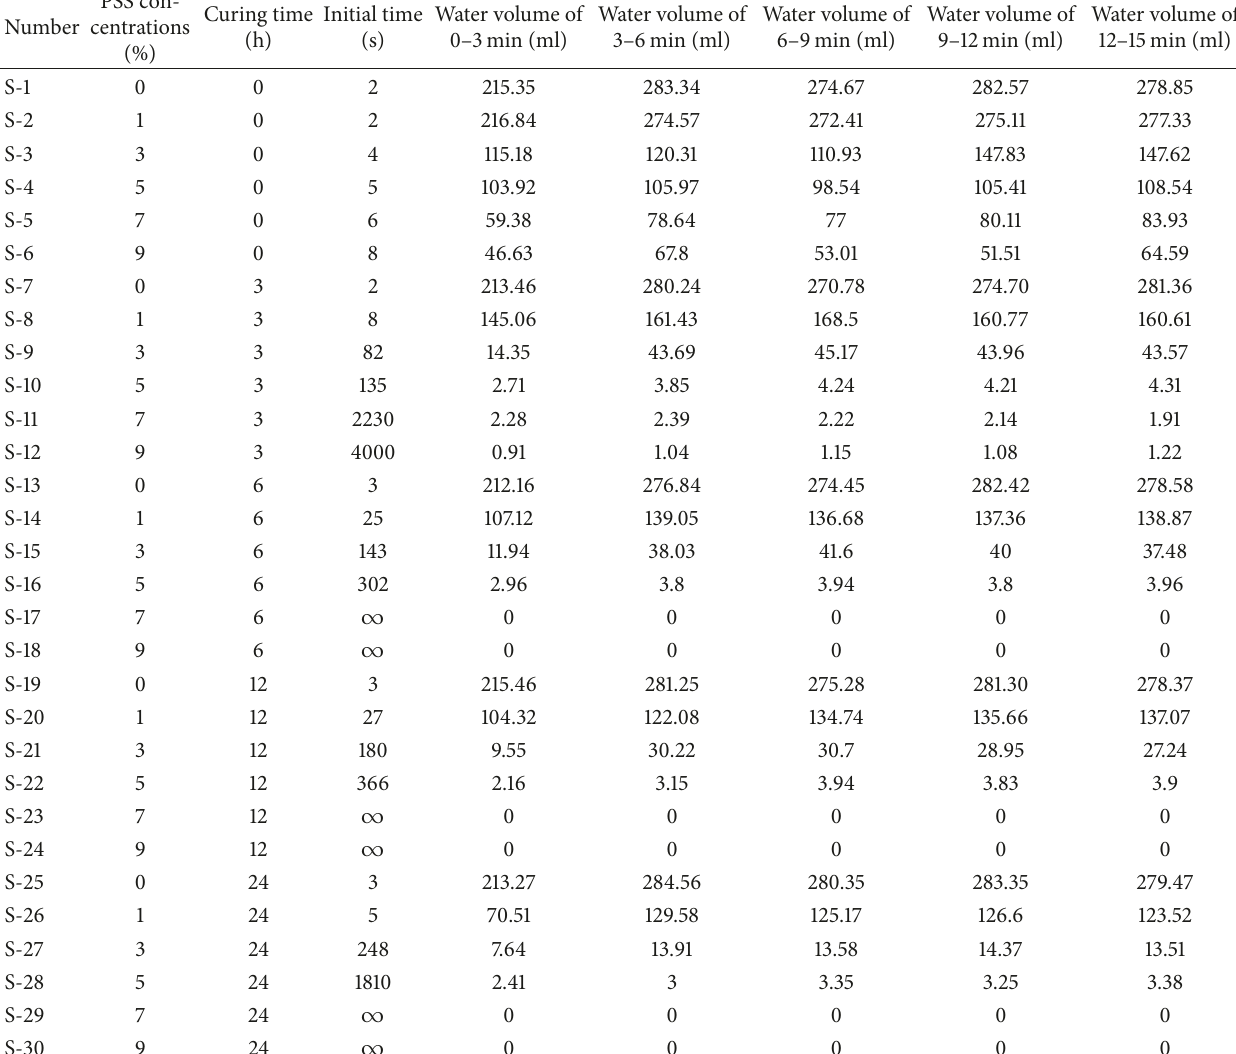
Table 2: Results of single-hole permeability